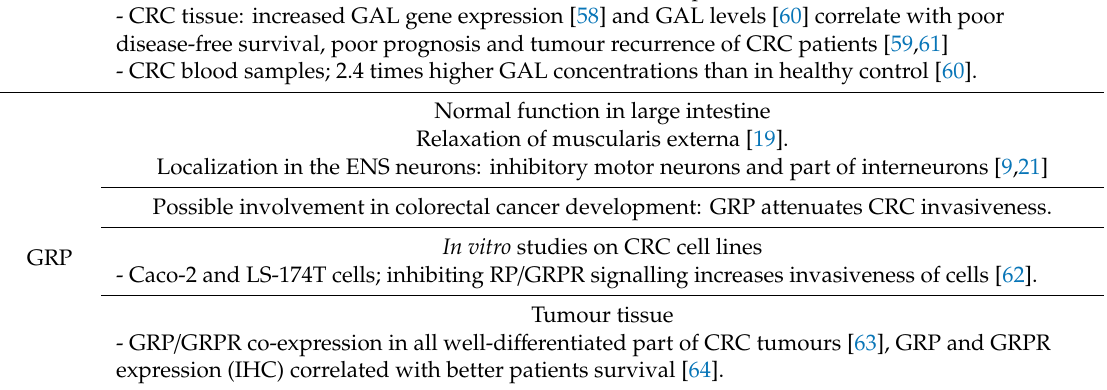
Table 1 Function and localisation of the ENS neurotransmitters in the normal human large intestine and colorectal cancer cell lines and tumour